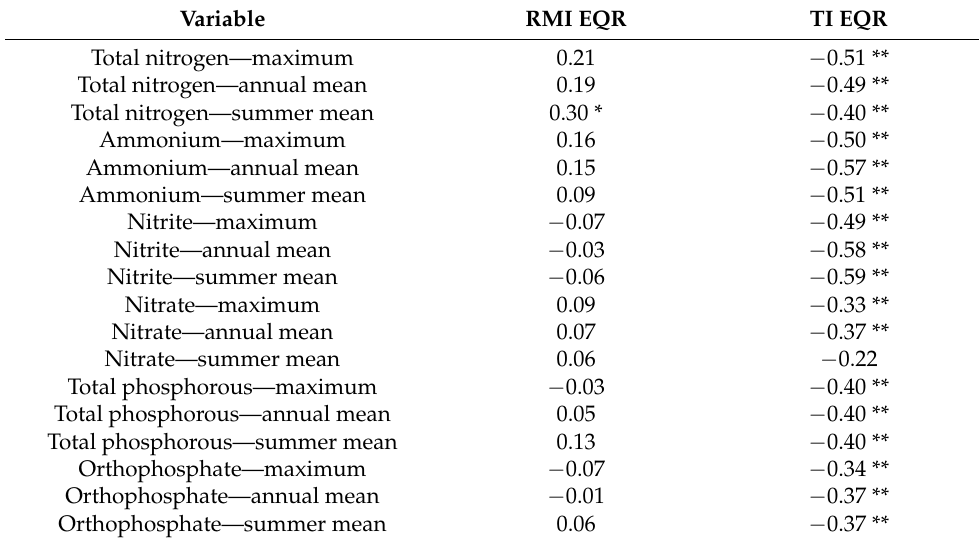
Table 4. The relationship (Spearman rank correlation coefficients) between the nutrient variables and the ecological quality ratio of the River Macrophyte Index (RMI EQR) and the Trophic Index (TI EQR); n = 70. Statistically significant relationships are marked **— p < 0.01 and *— p < 0.05. Variable RMI EQR TI